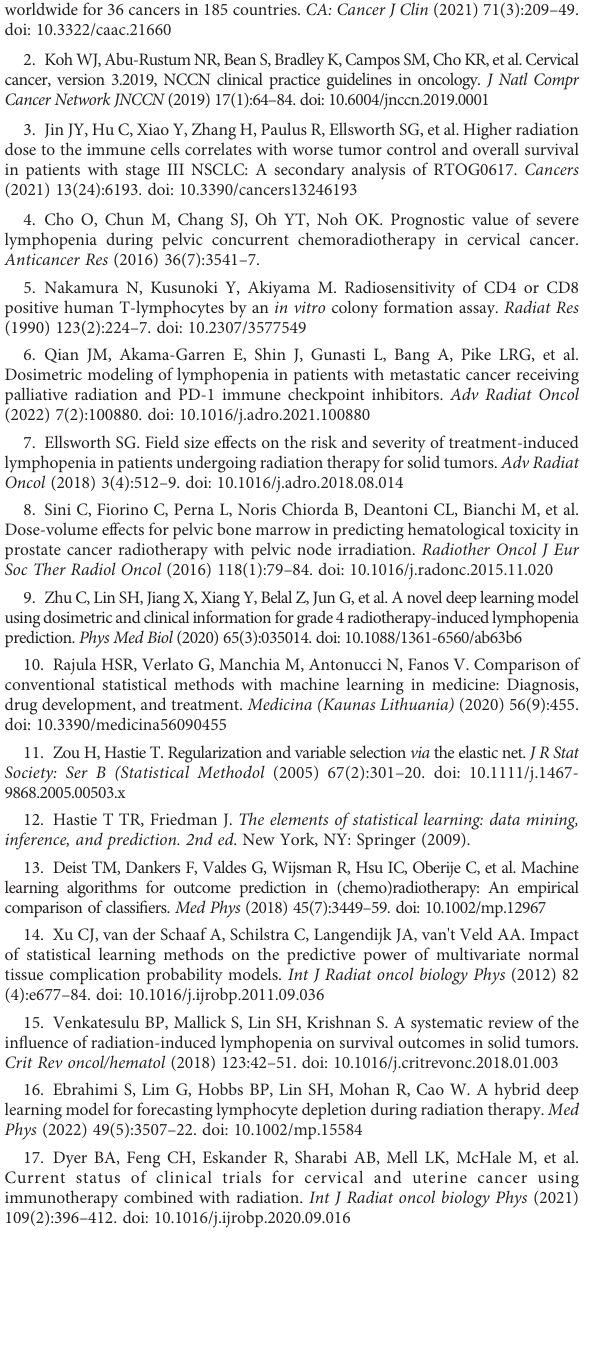
SUPPLEMENTARY FIGURE 1 The Pearson ’ s correlations among clinical characteristics and dose- volume histogram (DVH) metrics. SUPPLEMENTARY FIGURE 2 The selected frequencies of 14 clinical characteristics and 63